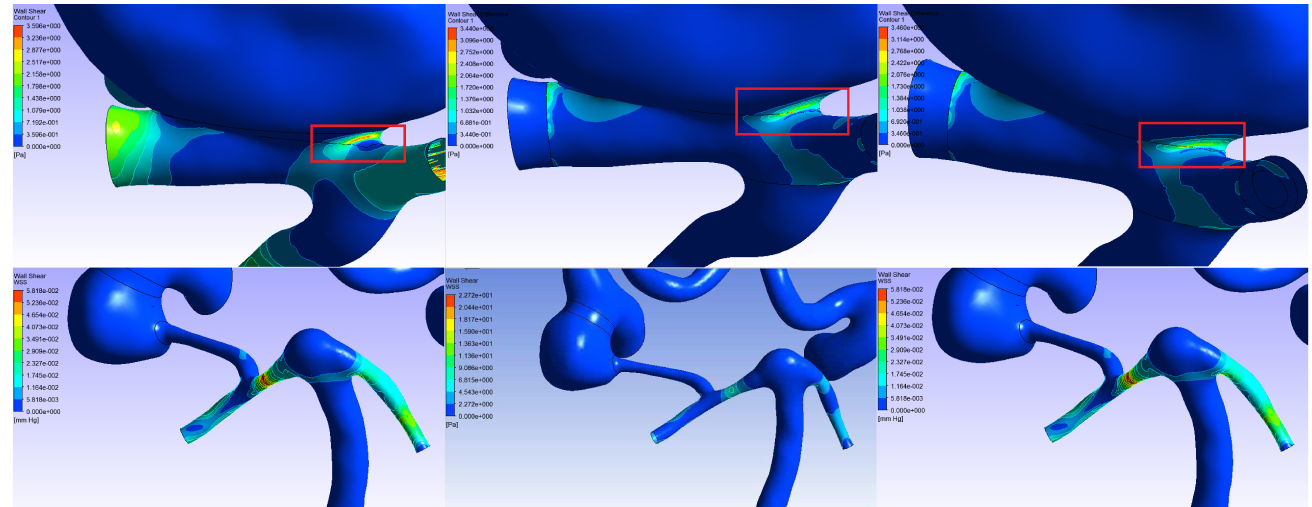
Figure 7. The ∆ WSS (7) for 3 scenarios of steady numerical modeling: (on the left ) scenario A, (in the center ) scenario B, (on the right ) scenario C. The first and second lines show the stress values for Patients 1 and 2,